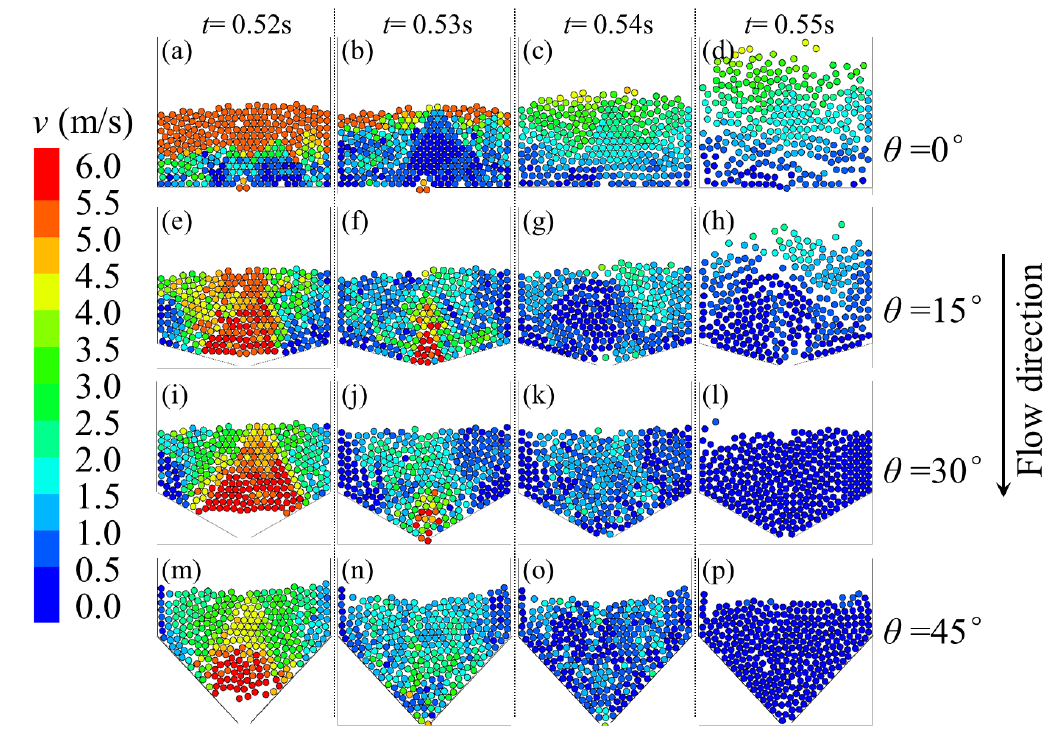
Figure 3. Schematic diagram of the velocity variation of the particle impacting the baffle structure with different inclination angles obtained from the DEM simulation. t is the time that the particles begin to move and fall.